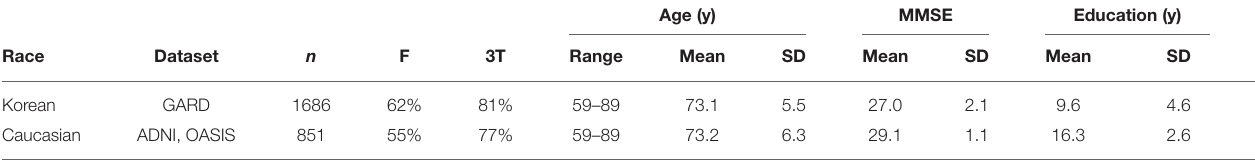
TABLE 1 | Cohort sizes and demographics for normal Koreans and